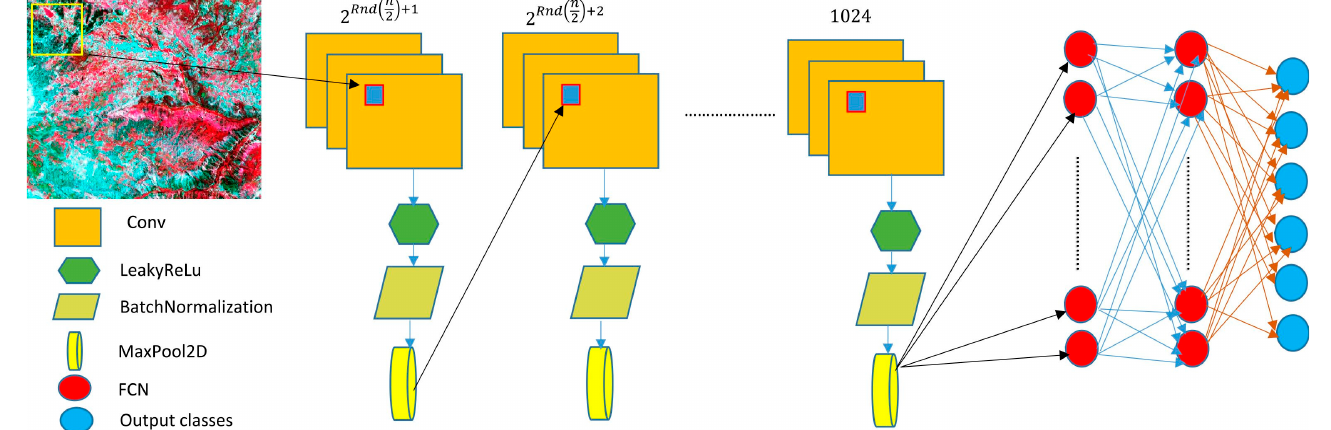
Figure 6. The inner structure of the FlexibleNet model.